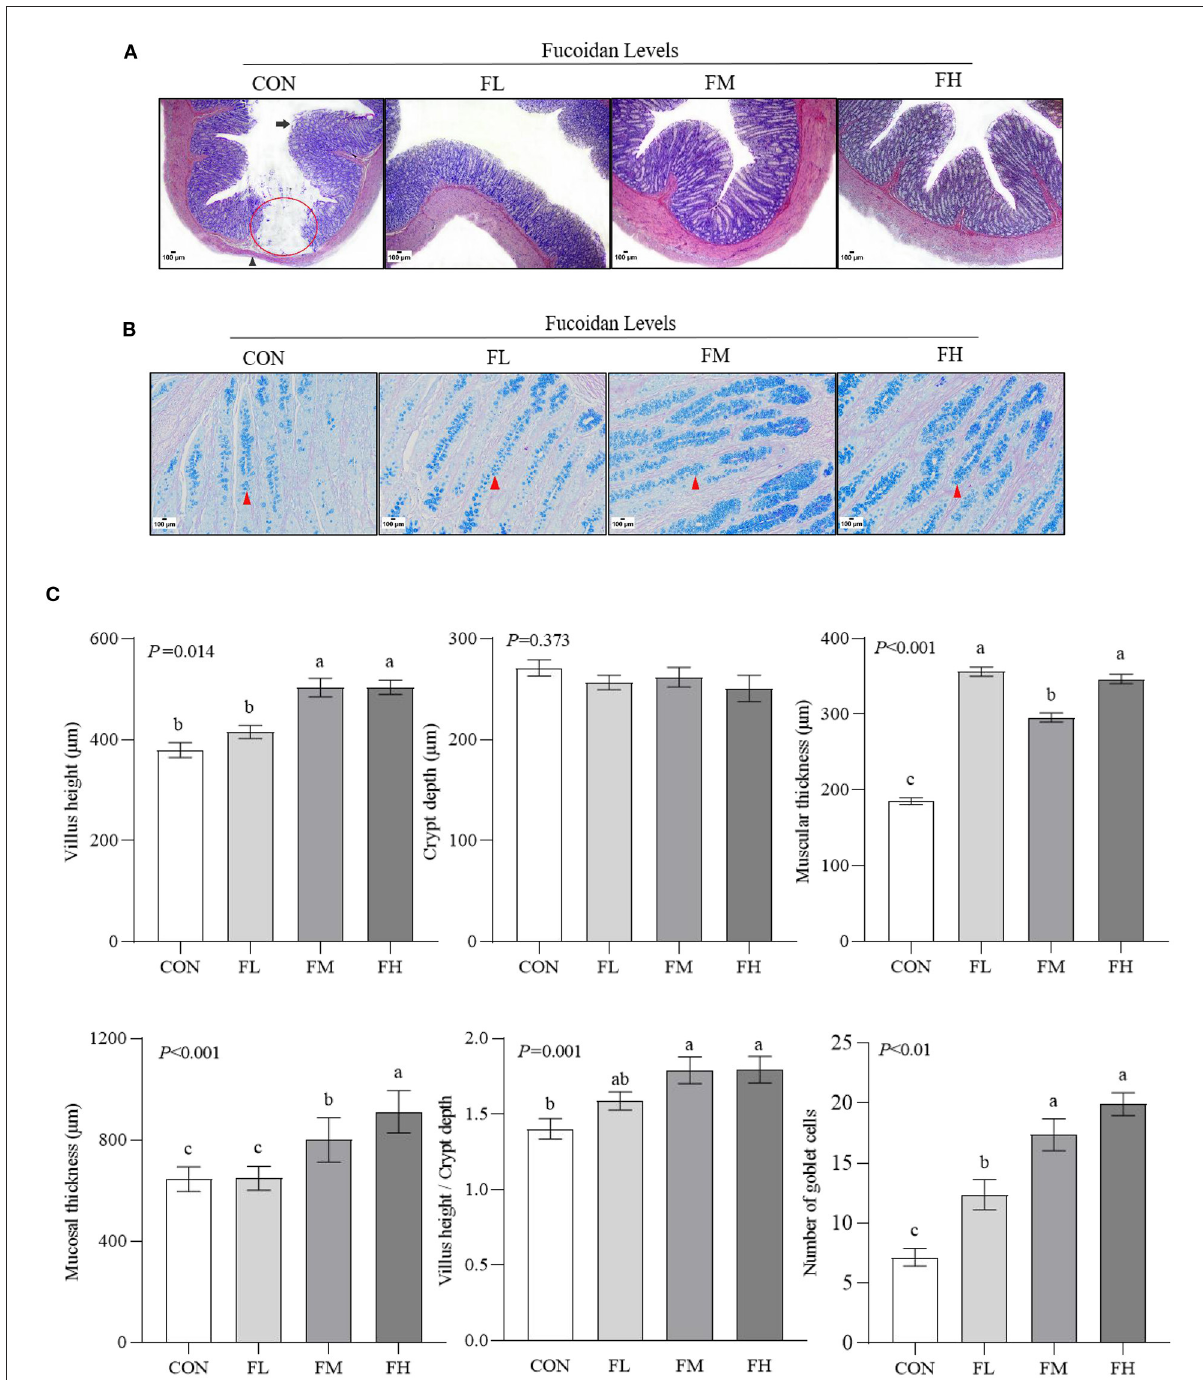
FIGURE3 The effects of fucoidan on the colon morphology and goblet cell count of weaned lambs ( n = 3). (A) HE staining results of colon paraffin sections (40 × ). The red circle indicates the absence of intestinal mucosa; the long black arrow shows the shedding of mucosal epithelial cells; the black arrowhead shows muscular atrophy. (B) D-PAS staining results of colon paraffin sections (200 × ). The red arrowhead shows the goblet cell (blue). (C) Morphology and goblet cell number in lamb colons were analyzed. CON, control; FL, 0.1% fucoidan (DMI); FM, 0.3% fucoidan (DMI); FH, 0.6% fucoidan (DMI). Data are denoted as mean ± SEM ( n = 3). a,b,c Demonstrate a statistically significant distinction, P <